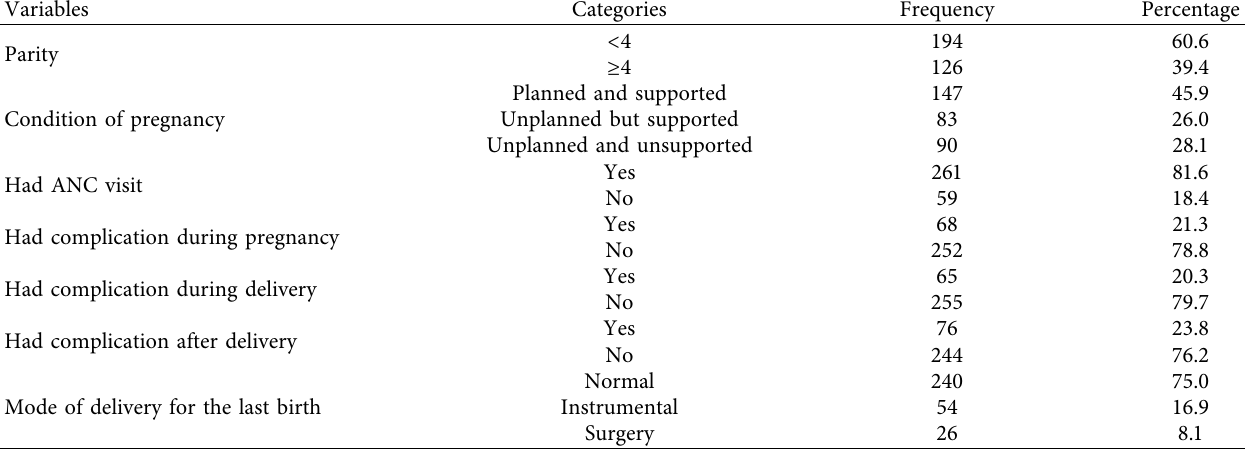
ETB � Ethiopian Birr. Table 2: Obstetrics complications and reproductive characteristics of the study participants in Hawassa Zuria district, Sidama Regional State Ethiopia,